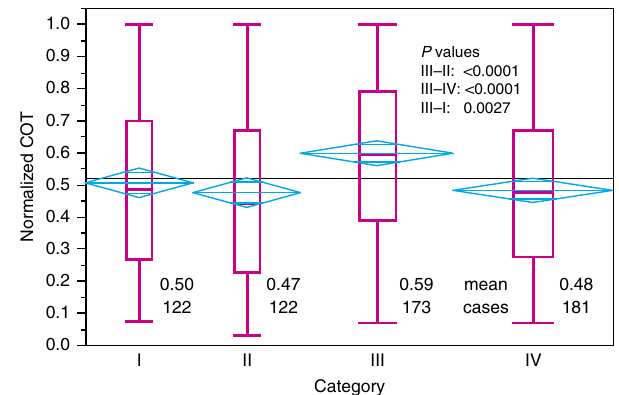
Figure 4 | Effect of advection. The effect of advection presented as displacement perpendicular to the flight track versus the angular difference between aircraft heading and wind direction. The colour coding refers to the absolute time difference between aircraft and CALIPSO.